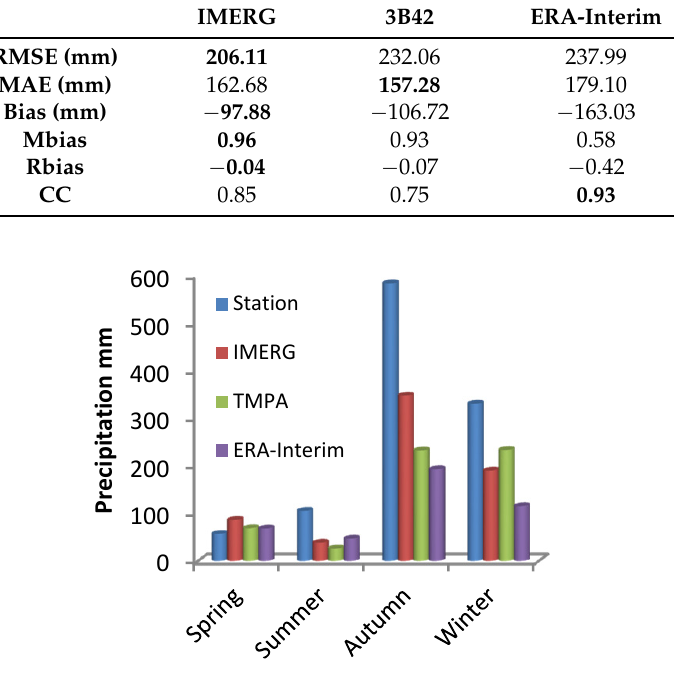
Table 12. Statistical indices of seasonal precipitation in Guilan area.